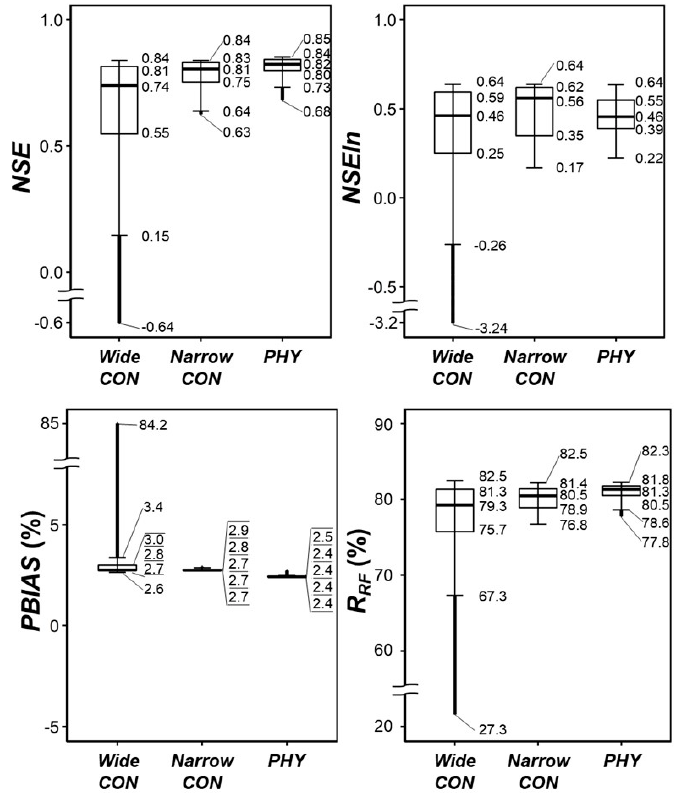
Figure 5. Accuracy statistics of predicting TDR and uncertainty ranges of R RF calculated using the conceptual and physically-based parameter approaches. The height of a box plot is the interquartile range (IQR) (or the distance between the 25th and 75th percentiles). The ends of whiskers represent the minimum and maximum values. Circles outside the whisker ends are outliers.